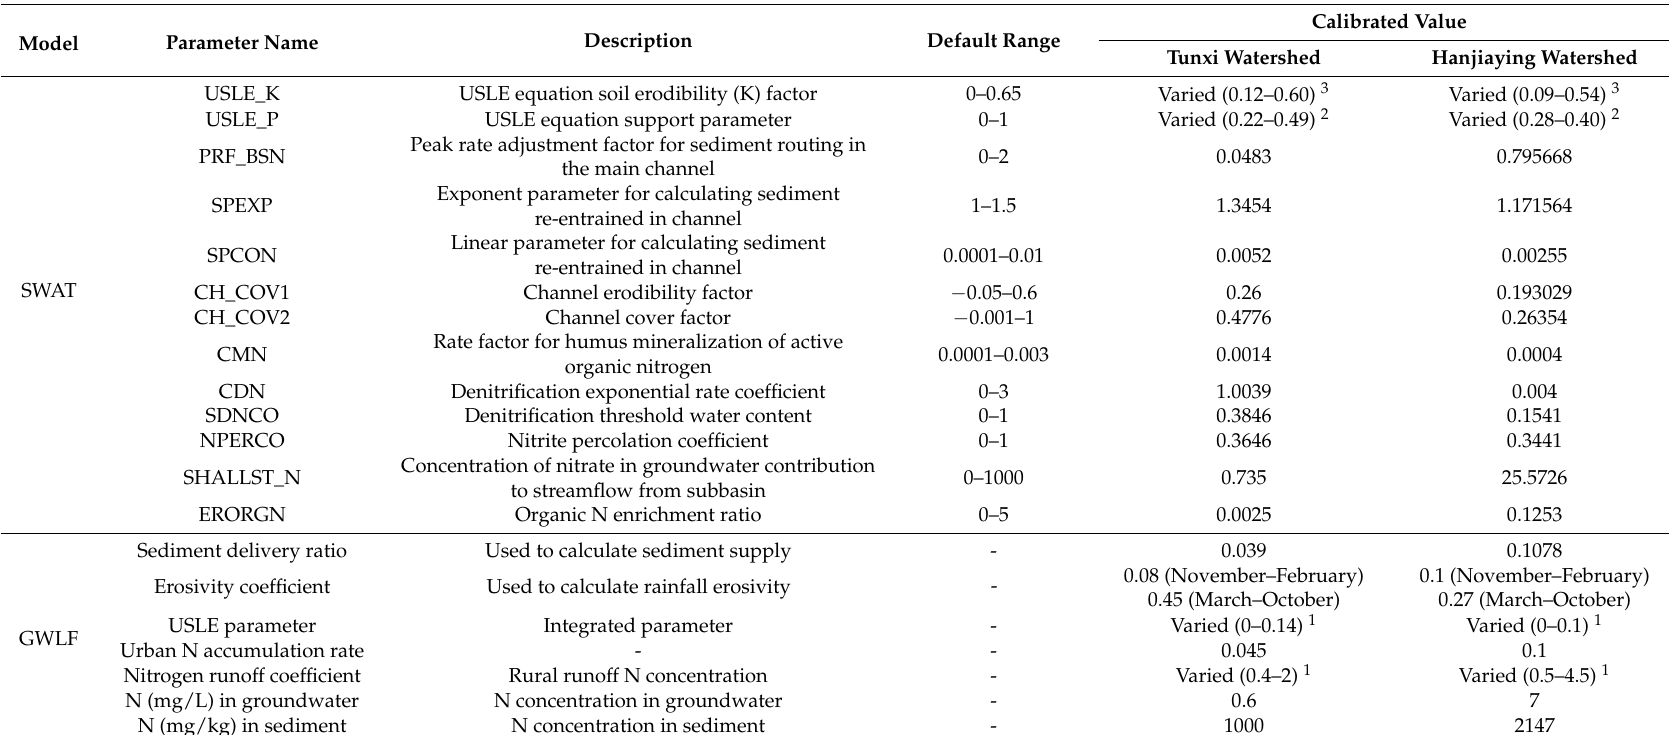
Table 4. Parameters selected for the calibration for